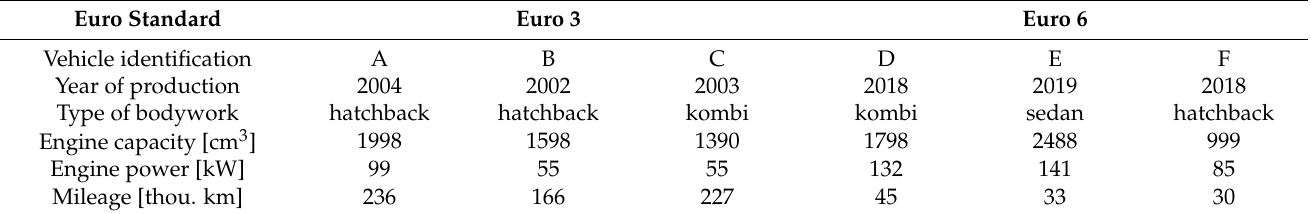
Table 1. Test vehicles data